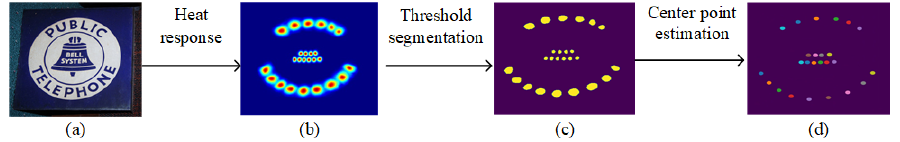
Figure 3. The workflow of character center node estimation. ( a ) Source image. ( b ) Heatmap. ( c ) Segmentation result. ( d ) Character center